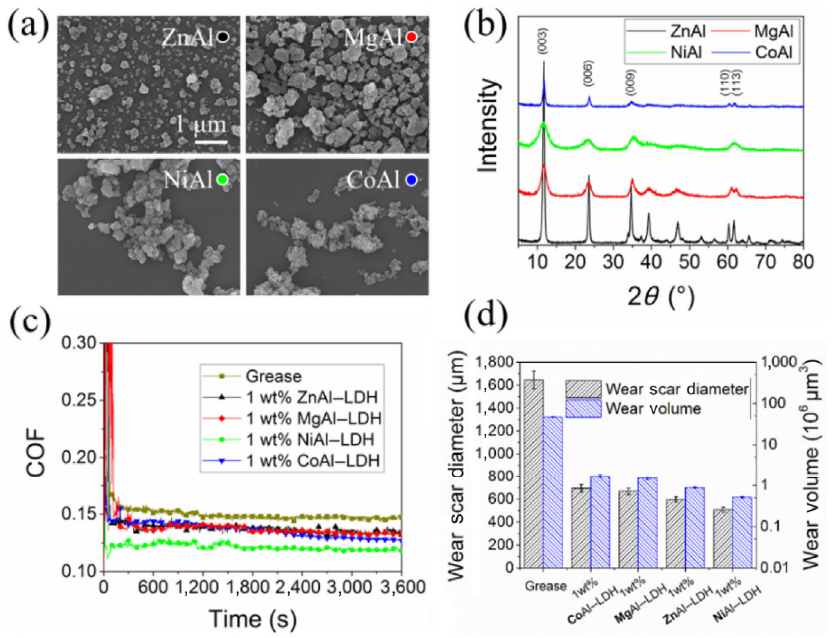
Fig. 2 (a) SEM images and (b) XRD patterns of ZnAl–, MgAl–, NiAl– and CoAl–LDHs. (c) Friction coefficient and (d) wear condition of base grease and those with 1 wt%